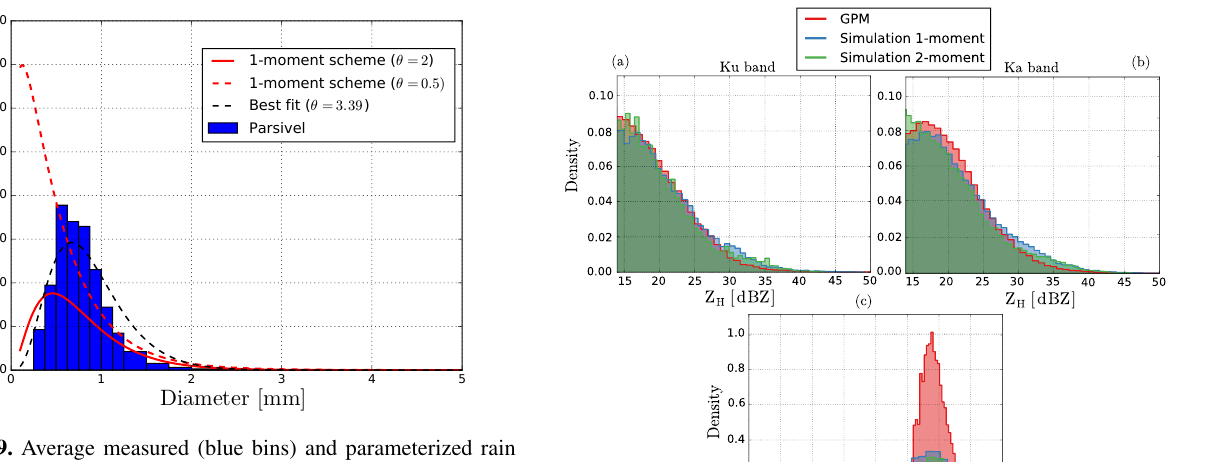
Figure 19. Average measured (blue bins) and parameterized rain DSDs at the ground in Payerne over six stratiform precipitation events. The dashed black line corresponds to the best fit of a gamma DSD on the measurements